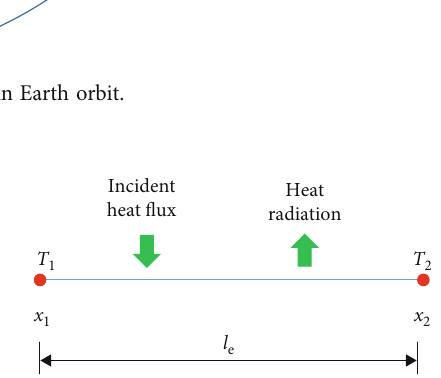
Figure 3: Two-node 1D thermal